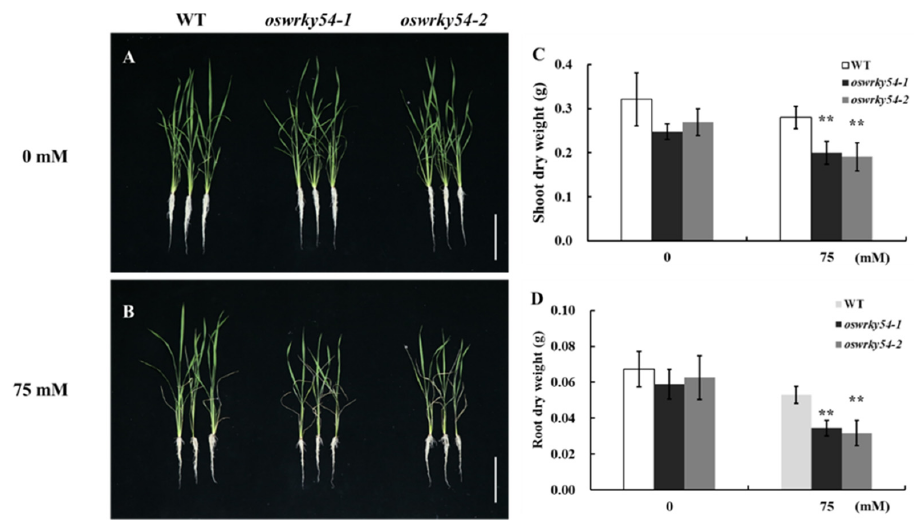
Figure 4. Knockout of OsWRKY54 reduces rice salt-tolerance. ( A , B ) Growth phenotype of WT and two oswrky54 mutant lines after treatment with 0 ( A ), 75 ( B ) mM NaCl for 14 days. Scale bar = 10 cm. ( C , D ) Dry weight of the roots and shoots in WT and two oswrky54 mutant lines after treatment with 0 or 75 mM NaCl. Thirty-d-old rice seedlings were subjected to 0 or 75 mM NaCl for fourteen days. Data represent mean ± SD (n = 4). Asterisks denote a significant difference (** p < 0.01; Tukey’s test).